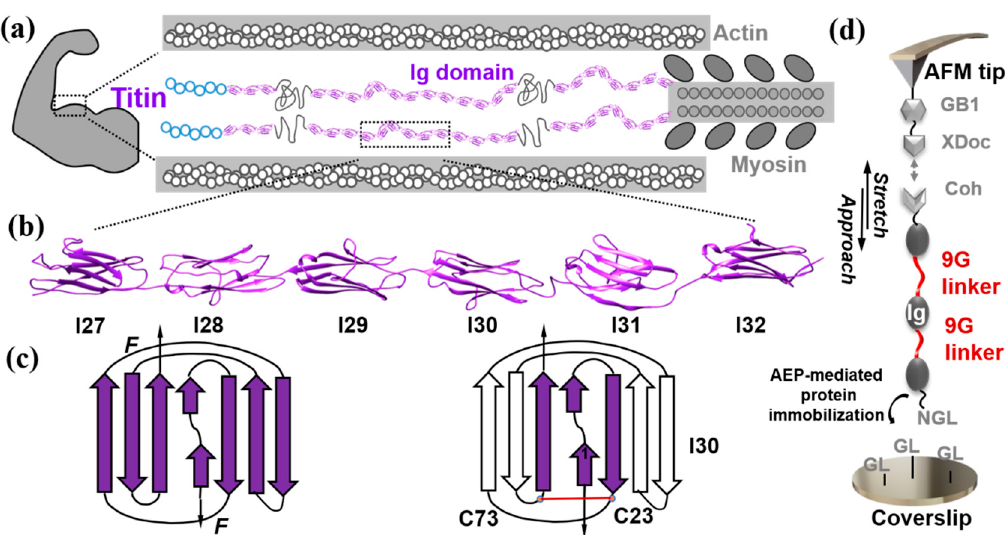
Figure 1. ( a ) Schematic architecture of one-half of the sarcomere highlights the polyprotein structure of giant protein titin (colored in purple), not in scale. ( b ) Structure shows human titin segment I(27–32) chosen for mechanical stability measurements. Except for I27 (PDB:1TIT), all others are simulated structures. ( c ) The cartoon shows the structure of I30 with a possible disulfide bond between Cys73 and Cys23, while no disulfide is present in other Ig domains. ( d ) The schematic shows how high-precision AFM-SMFS measures the mechanical stability of Ig domains with an artificial linker.